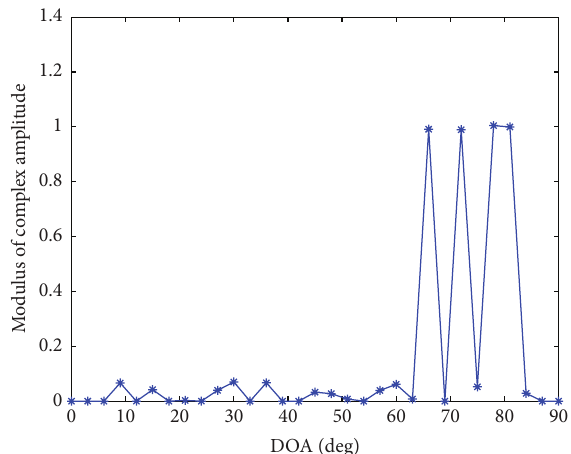
Figure 9: DOA estimation using the proposed coherent column replacement method.